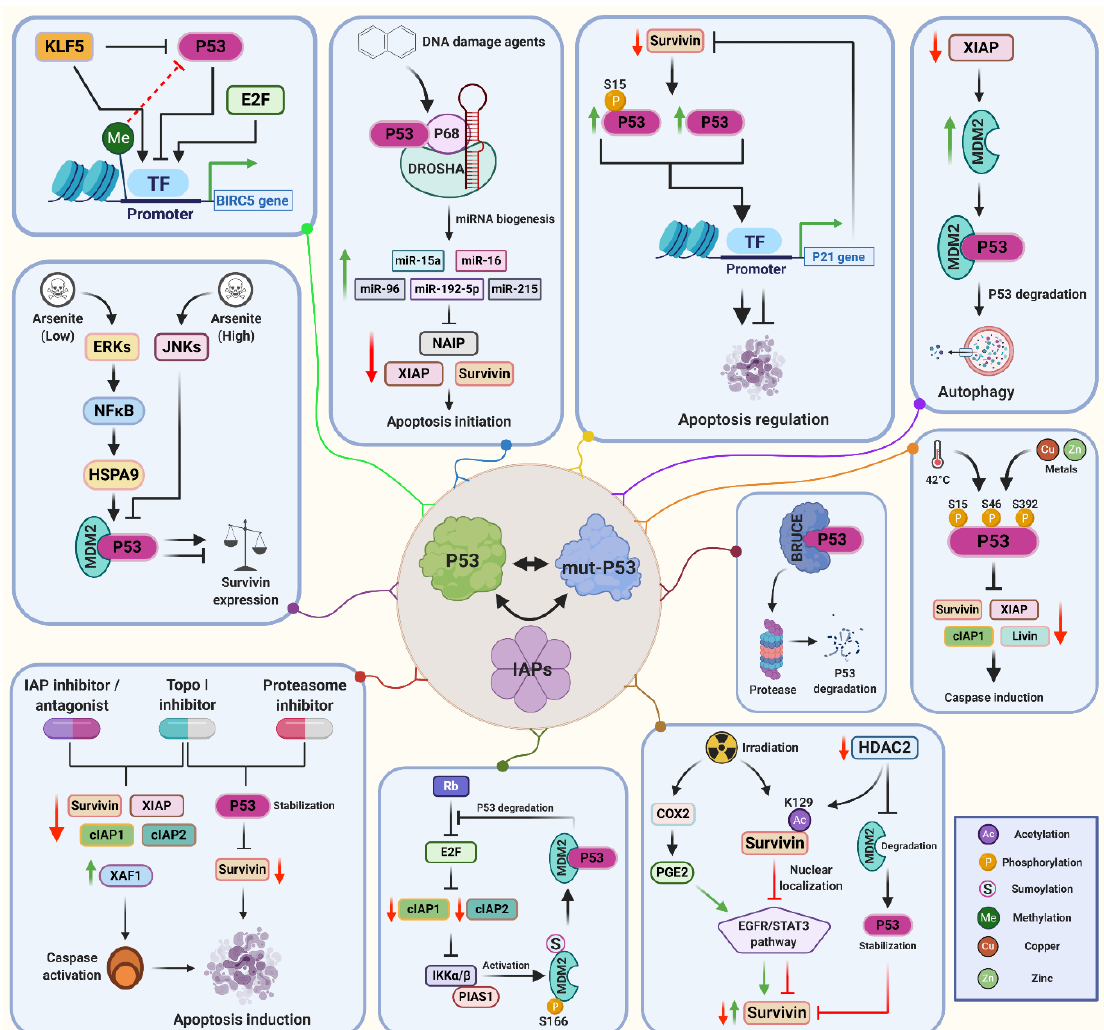
Figure 2. The IAP-p53 axis is an essential regulator of a multitude of cellular pathways. P53 is a key transcriptional suppressor of Survivin expression. Upon varying levels of different stress sources such as DNA damage agents, arsenite, heat and metal stress, activated p53 triggers caspase induction and apoptosis initiation via p21 expression and IAP-targeting of micro(mi)RNA biogenesis. Murine double minute 2 homologue (MDM2) as well as BRUCE function as upstream regulators of p53, whose binding arrests and directs it to targeted degradation. In addition, the IAP-p53 axis is also involved in the mediation of autophagy, epidermal growth factor receptor (EGFR)/ signal transducer and activator of transcription 3 (STAT3) pathway, NF-κB and alternative NF-κB pathways (Inhibitor of nuclear factor kappa-B kinase subunit alpha (IKKα)-mediated) under the regulation of MDM2 and histone deacetylase 2 (HDAC2). Details are given in the text. Abbreviations: BIRC5, BIR containing 5; cIAP1, cellular IAP1; cIAP2, cellular IAP2; Cox-2, cyclooxygenase-2; ERK, extracellular signal-regulated kinase; E2F, transcription factor E2F; HSPa9, heat shock protein family A (Hsp70) member 9; JNK, Jun kinase; KLF5, Kruppel-like factor 5; mut-P53, mutated p53; NAIP, neuronal apoptosis inhibitory protein; PGE2, prostaglandin receptor E2; PIAS1, protein inhibitor of activated STAT 1; Rb, Retinoblastoma protein; TF, transcription factor; Topo I, topoisomerase I; XAF1, X-linked inhibitor of apoptosis factor 1; XIAP, X-linked inhibitor of apoptosis protein.